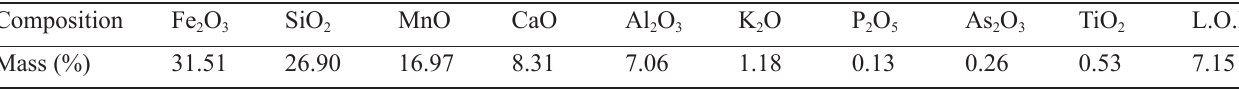
Table 1. Chemical analysis (XRF) of the siliceous manganese sample.